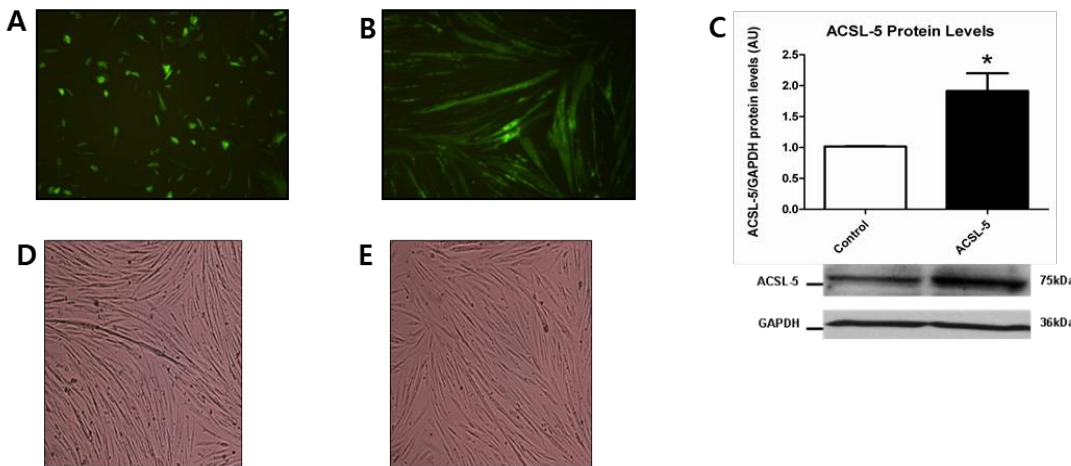
Figure 1. GFP fluorescence and ACSL-5 overexpression with transfection in primary human skeletal muscle cells (10X magnification). ( A ) Primary human skeletal myoblasts were transfected using positive control vector GFP without ACSL-5 plasmid DNA to verify transfection. Results indicated an approximately 50% transfection efficiency at 24 h after transfection. ( B ) At day 7 of the differentiation period, GFP fluorescence was strongly expressed in the primary human skeletal muscle cells. ( C ) Transfection efficiency of ACSL-5 normalized to GAPDH (open bar, control cells; closed bar, ACSL-5 transfected cells). The protein levels of ACSL-5 were approximately 2-fold higher in ACSL-5 overexpressed cells than in control. Data are presented as mean ± SEM (n = 6). * p < 0.05 versus control. Blots were probed with antibodies recognizing ACSL-5 or GAPDH. ( D , E ) Effect of transfection on cell morphology (10 × magnification). ACSL-5 overexpression did not affect differentiation in human skeletal muscle cells based on the morphology of control (D) and ACSL-5 overexpressed cells (E).